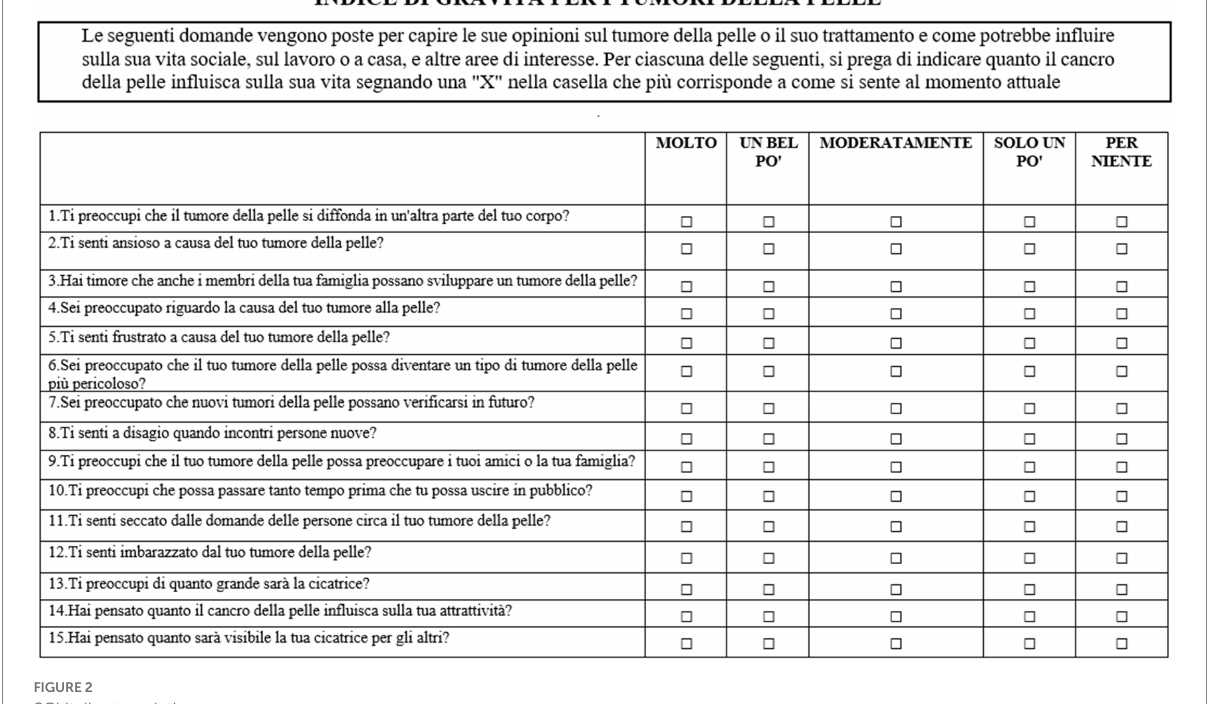
FIGURE 2 SCI Italian